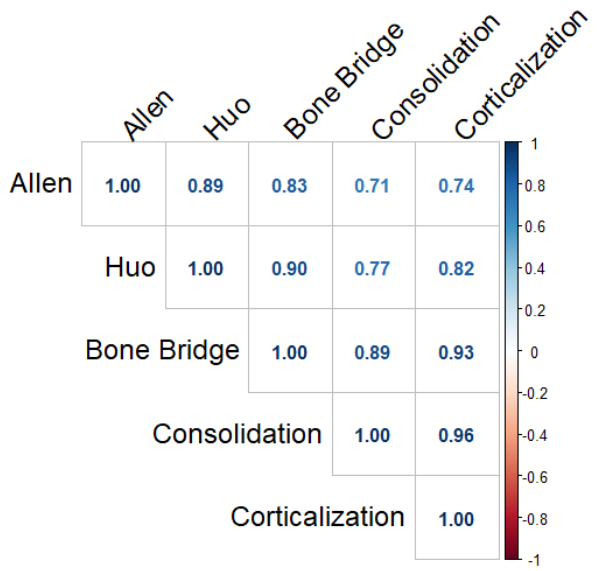
Figure 9. Spearman correlation coefficients between radiological and histological indices.